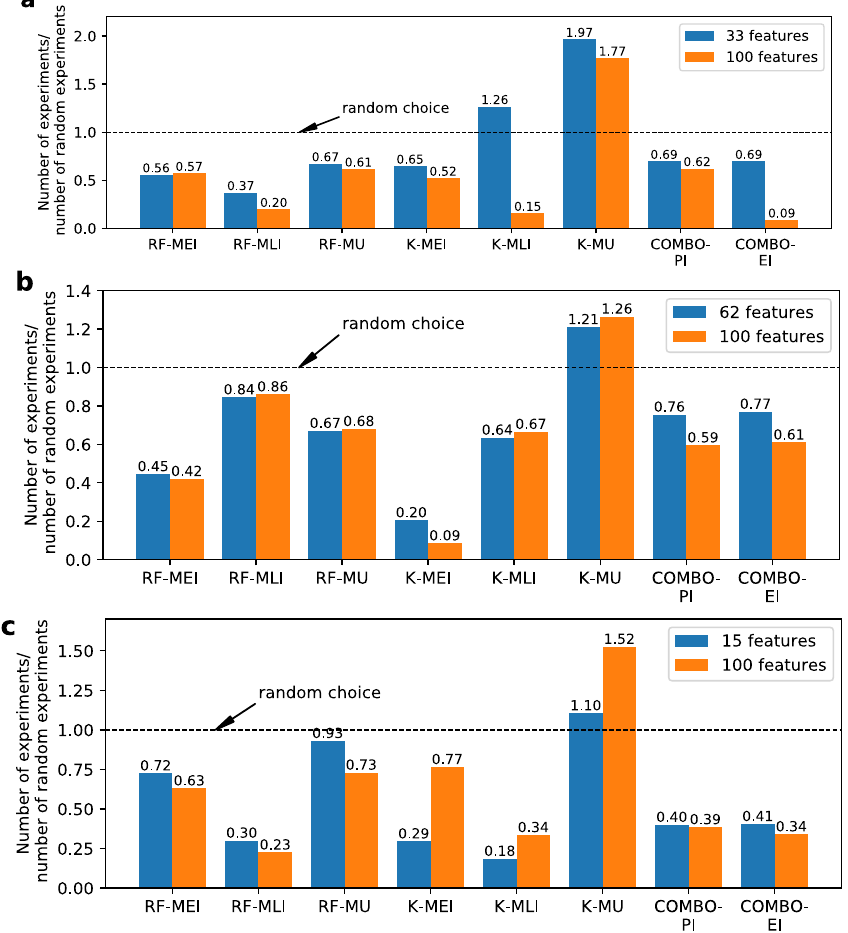
Fig. 4 Number of evaluations before converging to the maximum for the SL algorithms, normalized with respect to the random choice (corresponding to 200 experiments), for three sorption properties of MOFs. Results are reported for a Henry coef fi cient for CO 2 , b working capacity for CO 2 , c Henry coef fi cient for H 2 O; the initial set consists of the same worst 100 candidates (in terms of the target property) from a random subset of 500 samples of the original